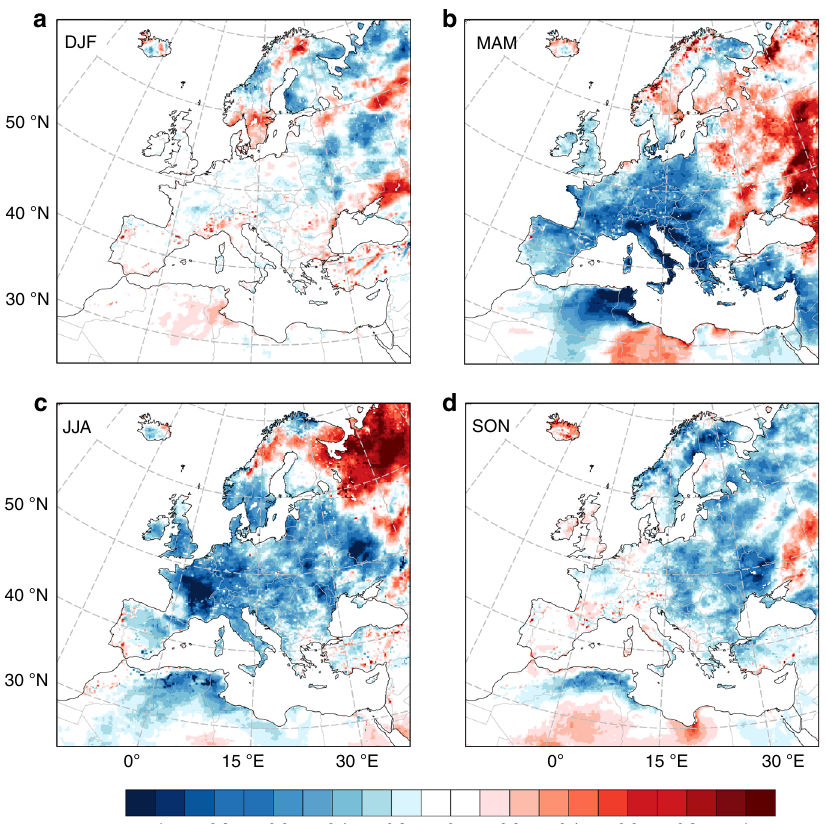
Fig. 4 Seasonality of the temperature changes from recent land cover changes in Europe. Average temperature changes (°C) in winter ( a ), spring ( b ), summer ( c ) and autumn ( d ). December, January and February (DJF); March, April May (MAM); June, July and August (JJA); September, October and November